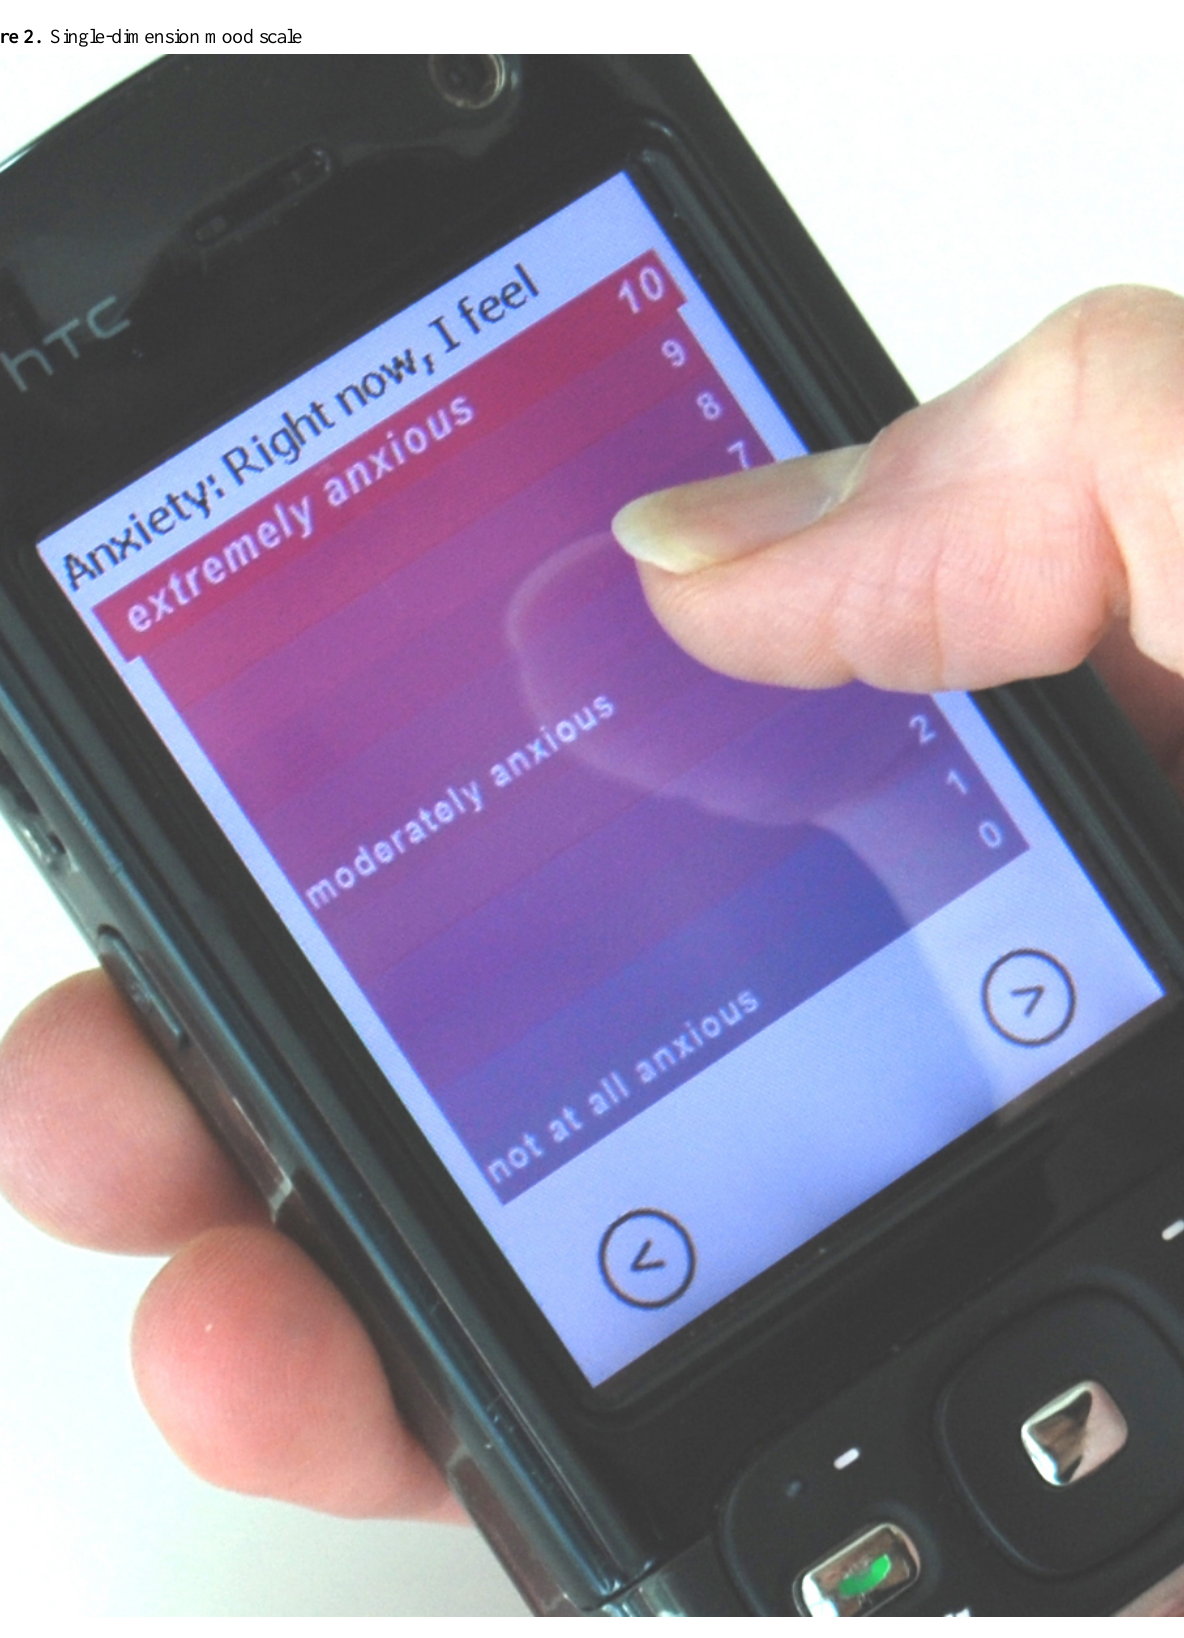
were arranged vertically on the screen, with an 11-point range. They were labeled with the specific emotion and were graded in color between the two endpoints. An example, the anxiety scale, is shown in Figure 2. Each scale proceeded from “not at all” (followed by the mood being captured, such as